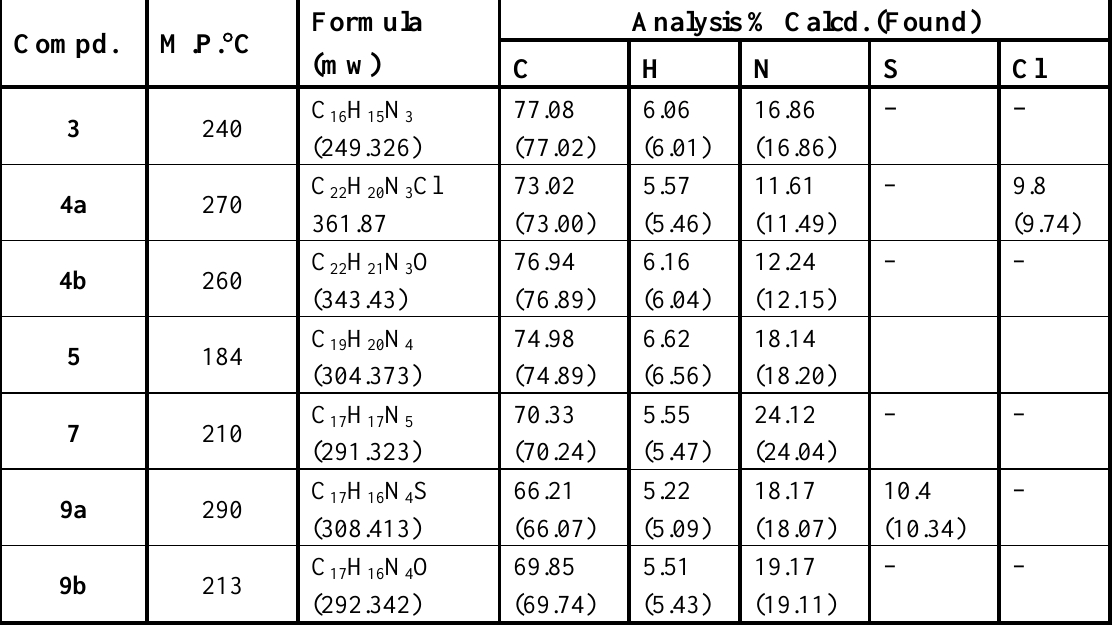
Table 4. Physical properties and elemental analyses of the new